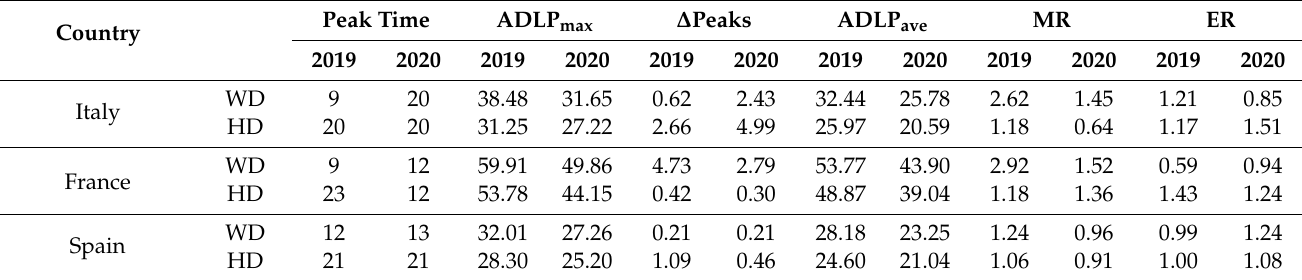
Table A2. Load profile analysis for some European countries, April 2019–2020 (in blue the EU countries). Peak Country